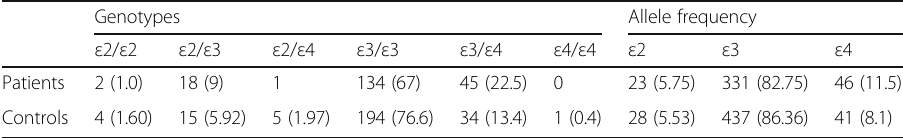
Table 2 Distribution of APOE genotypes and alleles in patients with aneurysmal SAH and in control subjects Genotypes